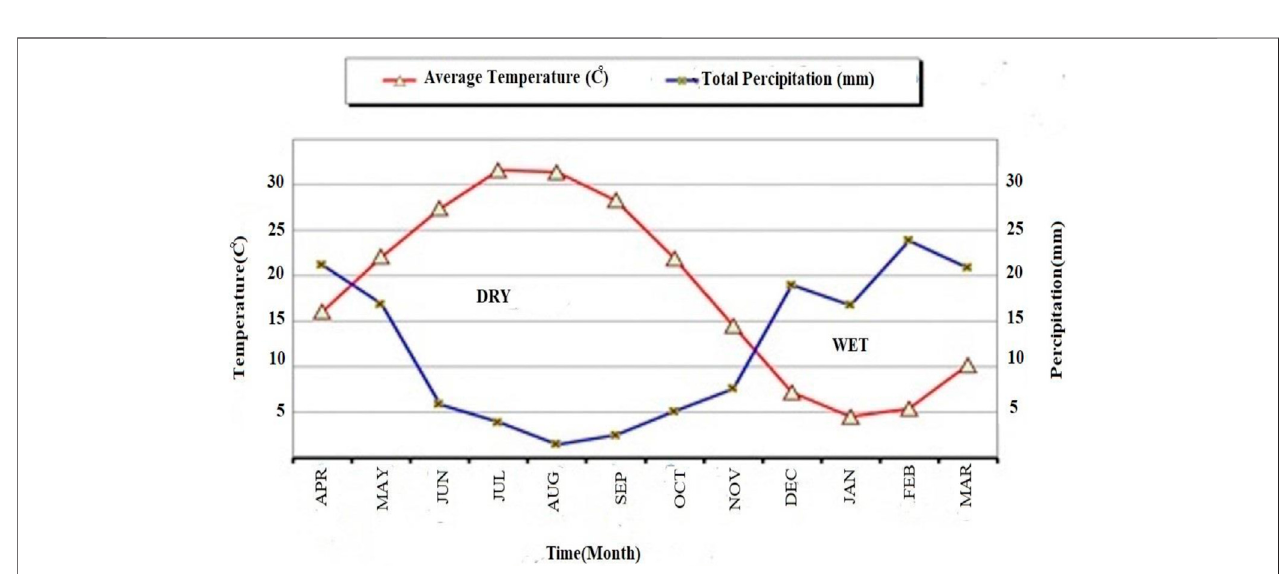
FIGURE 3 | Semnan 6-month drought index time series.